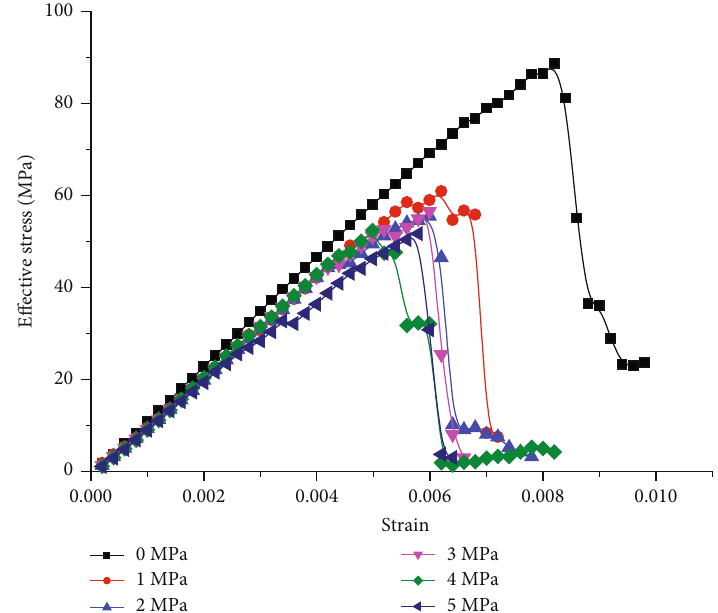
Figure 4: E ff ective stress-strain curves under di ff erent gas pressure with con fi ning pressure of 10